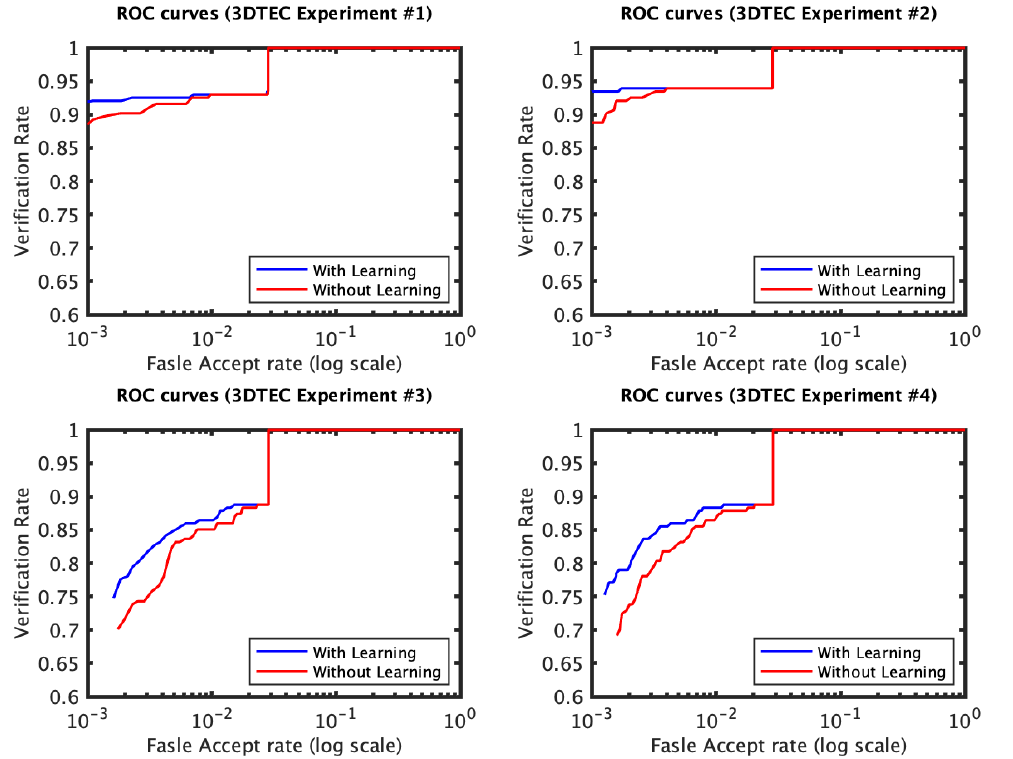
Figure 11. The ROC curves of the four 3D TEC experiments based on local 3D